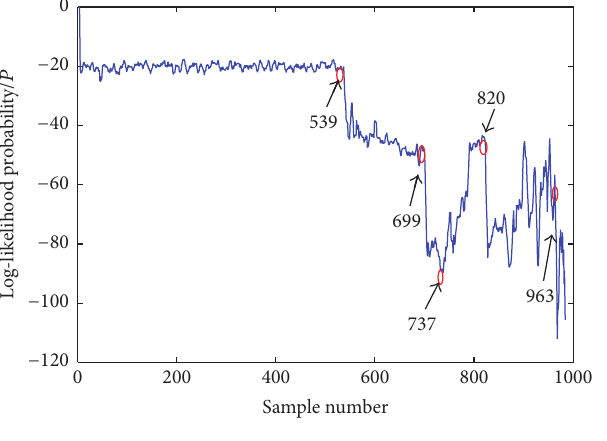
Figure 11: Assessment result using HMM.